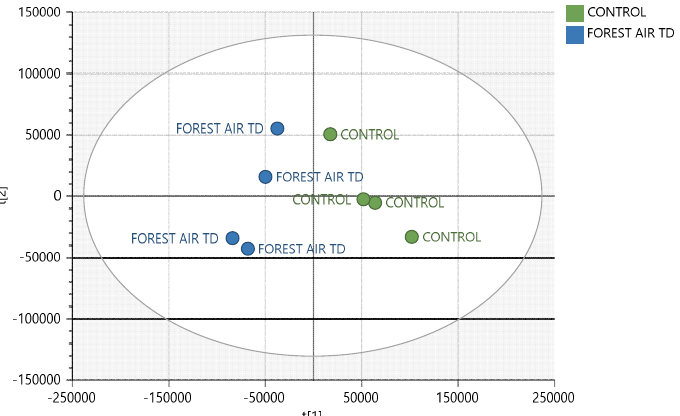
Figure 3. PCA plot of the global NVOC profile of the two different air types. Forest air vs. control air from the walled garden.